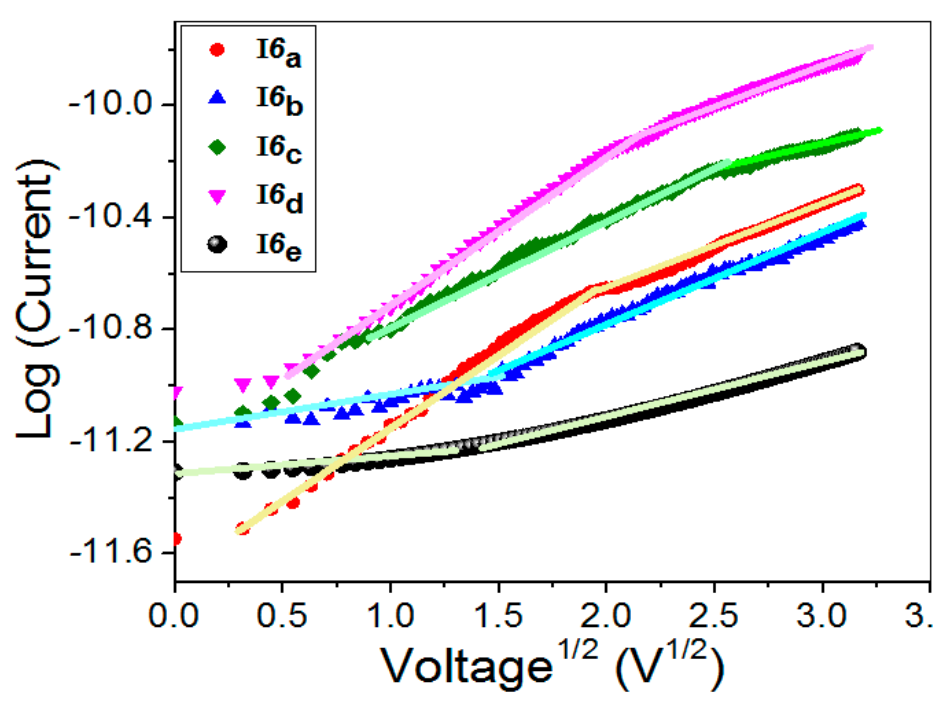
Figure 9. The relation between log (I) and V 1/2 .